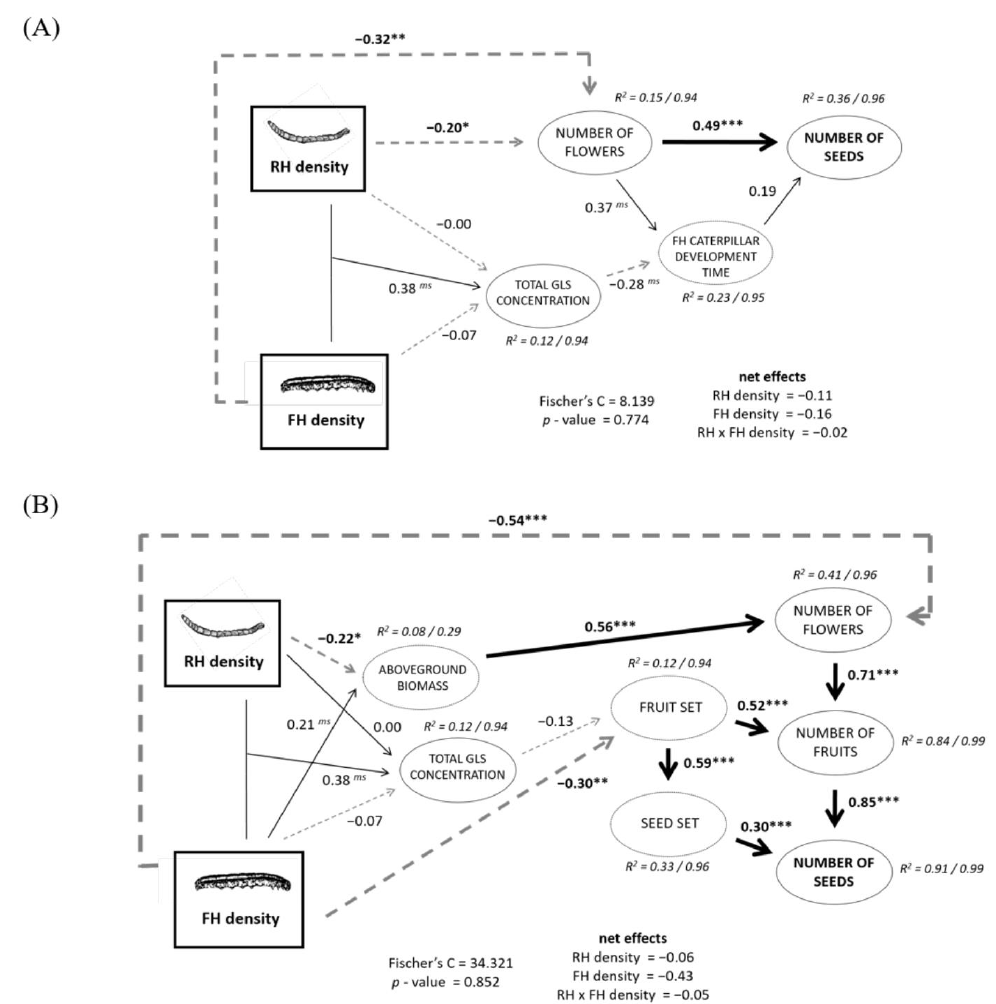
Figure 4. ( A ) Final piecewise SEM 1 parsing the direct, indirect, and net effects of RH and FH densities on plant reproduction (number of seeds) through FH caterpillar development time. ( B ) Final piecewise SEM 2 parsing the direct and indirect effects of RH and FH densities on sequential plant reproductive components and its net effects on plant reproduction (number of seeds). Fruit set was calculated as the proportion of flowers that passed to fruits, and seed set as the proportion of ovules that passed to seeds. For both ( A , B ), standardized path coefficients are shown next to each path, and their significance level is shown as ms P < 0.08, * P < 0.05, ** P < 0.01, *** P < 0.001. Solid lines denote positive and dashed lines negative relationships, and their thickness is scaled to the significance level. Variance explained by the component models (R 2 ) is reported as marginal/conditional.